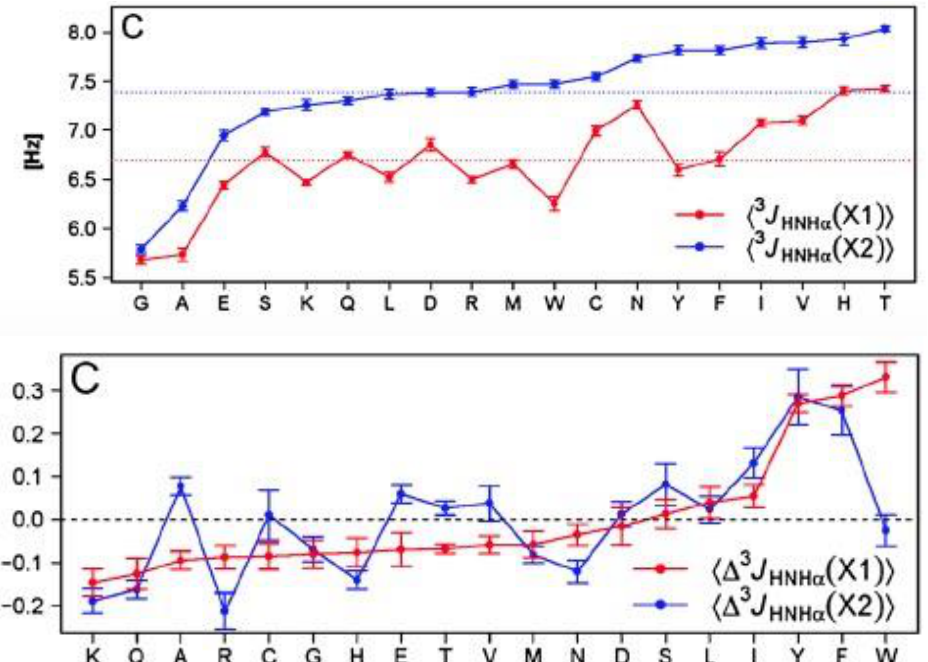
Figure 14. Upper panel: Average J-coupling constants of the indicated amino acid residues in blocked xy-tripeptides. Lower panel: Average effect of the upstream and downstream neighbors on the 3 J(H H H Cα ) constant of the indicated residues of blocked xy-tripepetides. Note that the authors’ x 1 and x 2 correspond to x and y of the notation used in this article. The character C in the upper left corner indicates that these figures are part of a figure set in [94], from where they were taken and modified.